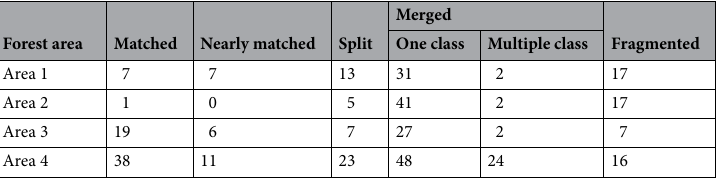
Table 1. Accuracy statistics of the tree crown maps. (Area 1: deciduous coniferous tree; Area 2: strobe pine forest; Area 3: slash pine and taeda pine forest; Area 4: naturally regenerated forest).